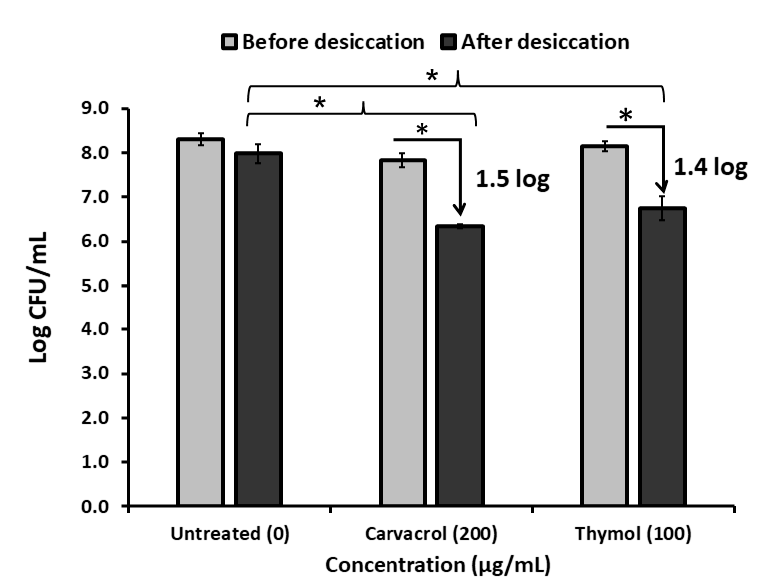
Figure 3. Changes in populations of desiccation-adapted Salmonella Tennessee E2007000304 when treated with 200 and 100 µg/mL of carvacrol and thymol, respectively, for 120 min at 37 °C and followed by desiccation for 24 h at 22–25 °C. Each data point represents mean ± standard deviation. Asterisk (*) denotes significant difference at p < 0.05.